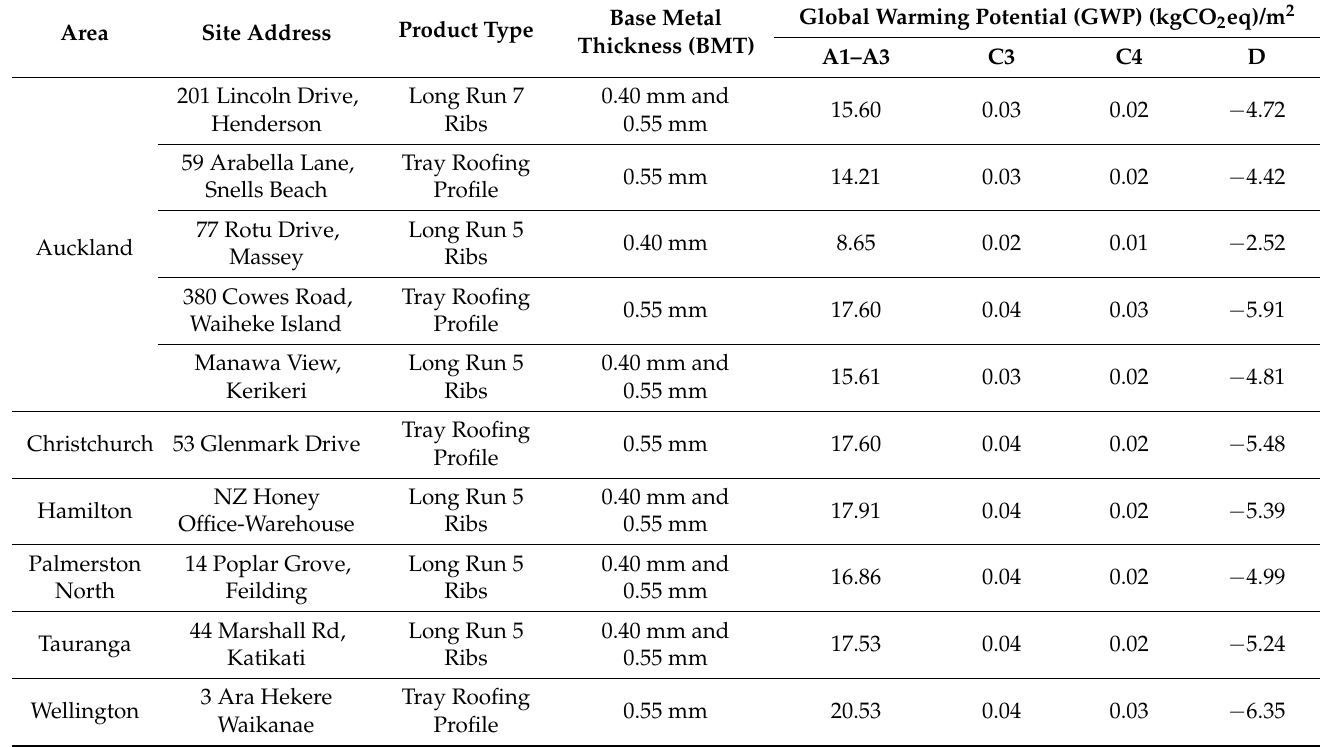
Table 3. GWP values of investigated specific metal